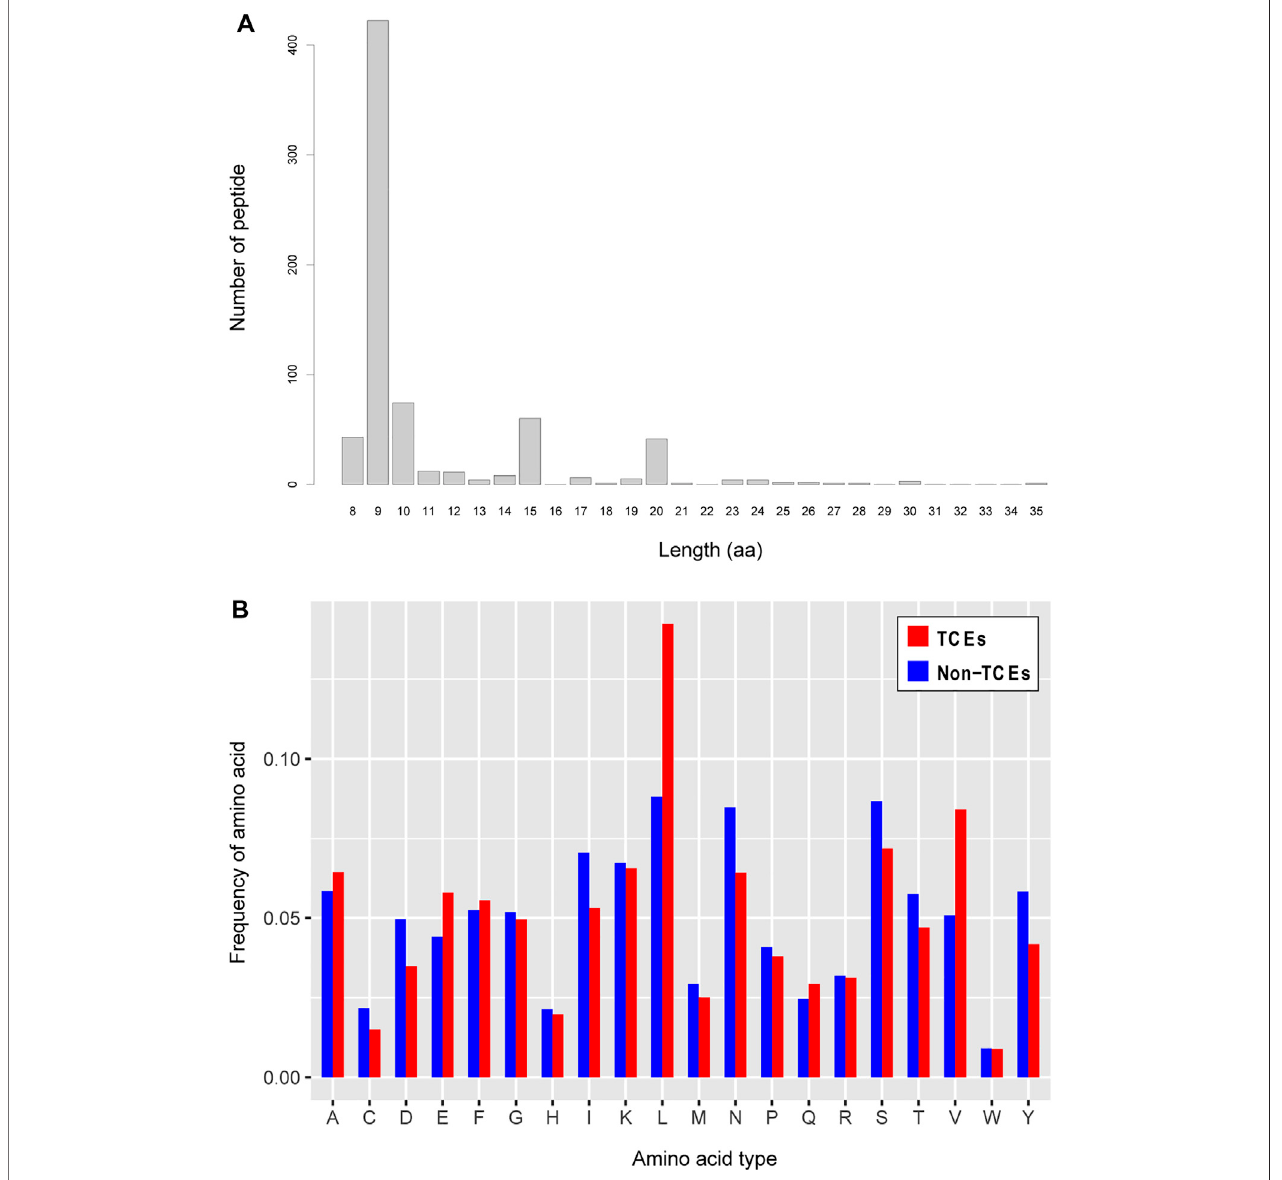
FIGURE 2 | Analysis of amino acid sequence features. (A) Length distribution of the positive CD8 + T-cell epitopes. The horizontal axis represents the length of amino acids, and the vertical axis represents the number of epitopes in positive samples. (B) Distribution features of amino acid types with respect to the positive and negative CD8 + T-cell epitopes. The horizontal axis represents the twenty amino acids, and the vertical axis represents the occurrence frequency of an amino acid in all sequences.